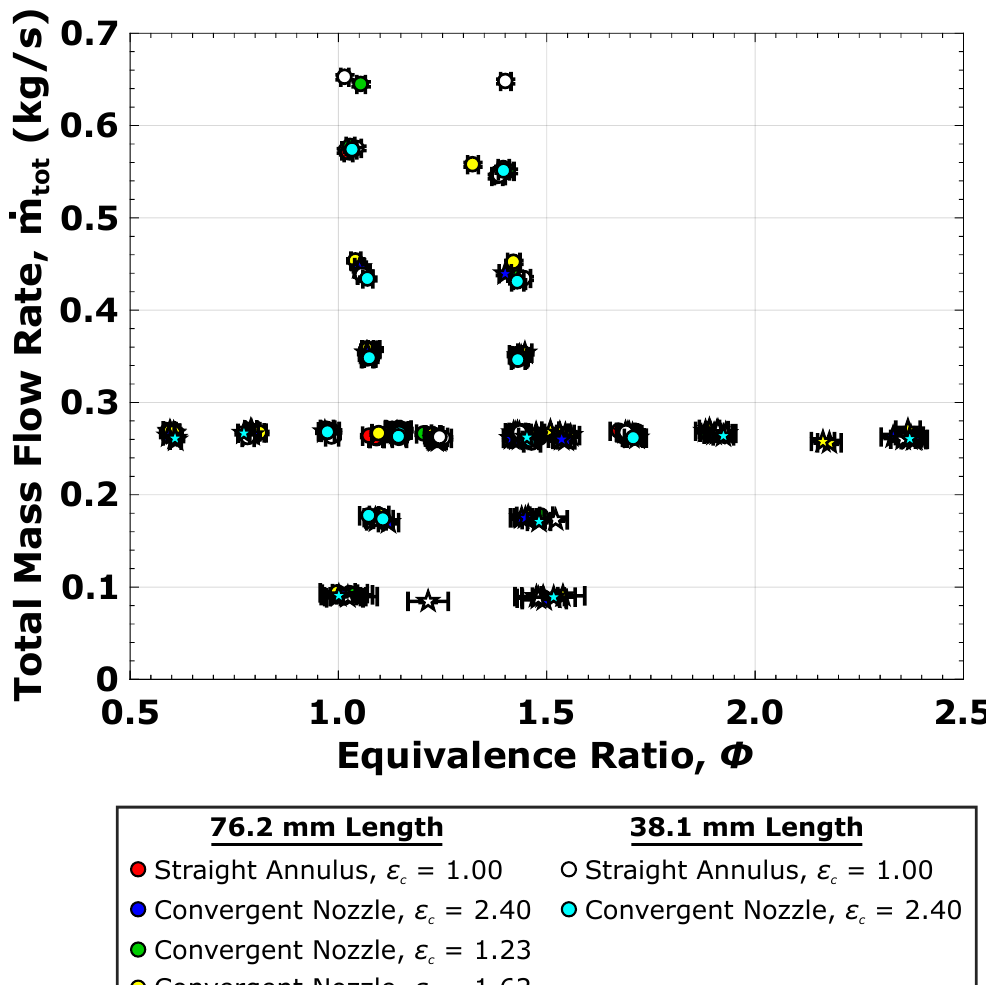
Figure 3. Flow condition test matrix for the various convergent nozzle geometries. In the previous experimental work, hot-fire tests of the RDRE were 1250 ms in du- ration [5,13]. However, due to the inclusion of the temperature-sensitive high-frequency pressure transducer, the firing times for all of these tests are reduced to 750 ms to increase the survivability of the sensor. Figure 4 compares two test firings of 1250 ms and 750 ms for the same flow condition, φ = 1.15 and ˙ m tot = 0.272 kg/s, showing the transient response of the test article pressures (left) and thrust (right) for the two firings. For both run durations, the upstream venturi and plenum pressures reach steady-state conditions throughout the entirety of the engine run time, whereas the oscillations present initially in the thrust measurement damp out during the last 100 ms of the firing. Therefore, the 100 ms duration bounded by the vertical dashed lines in Figure 4 is used for reporting the average run measurements. As the average test measurements captured during the 750 ms run are equivalent to the 1250 ms firing without significant noise added, this provides validation for the short-duration firing time. Measurement uncertainty for these reduced duration firings are calculated using the procedure described in Lightfoot et al. [17]. This uncertainty is presented as error bars on all of the subsequent test run measurement plots, which overall did not increase notably from previous extended firing results with 1250 ms run duration